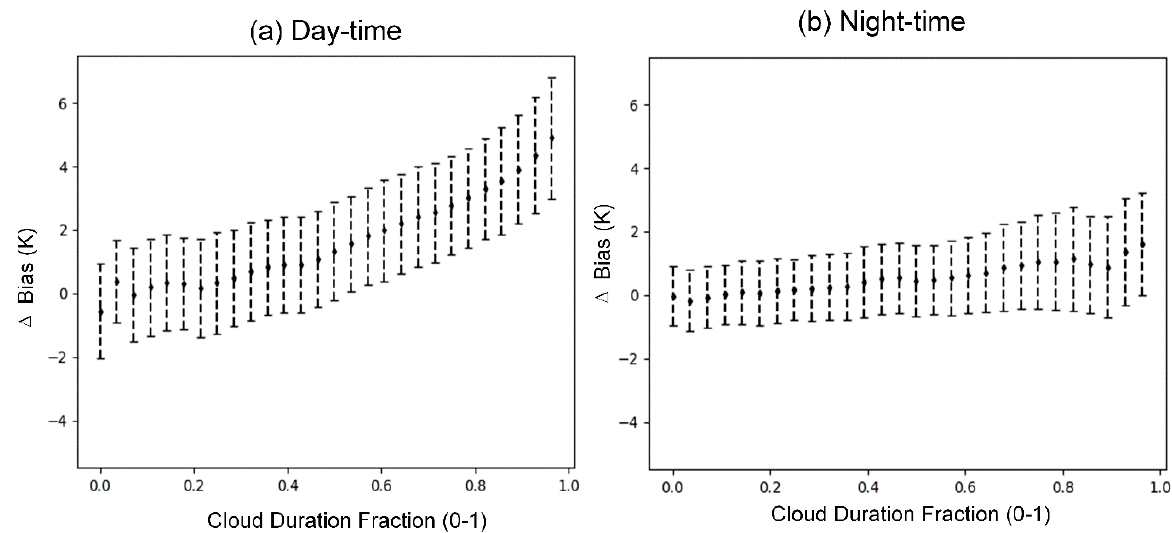
Figure 12. Outcome of the cloud duration analysis for the whole of Kenya with SEVIRI. Mean (solid point) and standard deviations (dotted line) of the evaluation metric ∆ bias of cloud gap-filled MODIS LST dataset according to different cloud duration fraction (CDF) groups. The evaluation is made at the pixel level of SEVIRI observations (pixel sizes of around 4 km over Kenya). This analysis highlights that during the day, the STDF+PMBC approach results in improved performance over the STDF-only approach, and this improvement increases with cloud residence time, as indicated by CDF. At night, bias correction offers little additional performance improvement.